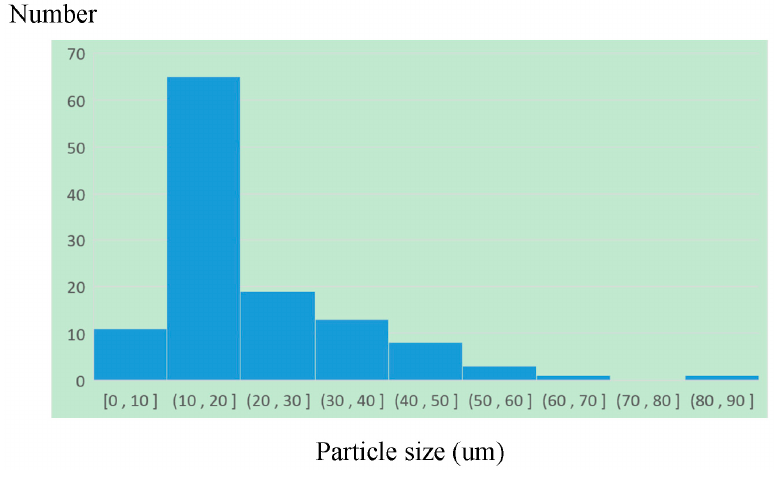
Figure 6. Histogram of fine sediment particle size.